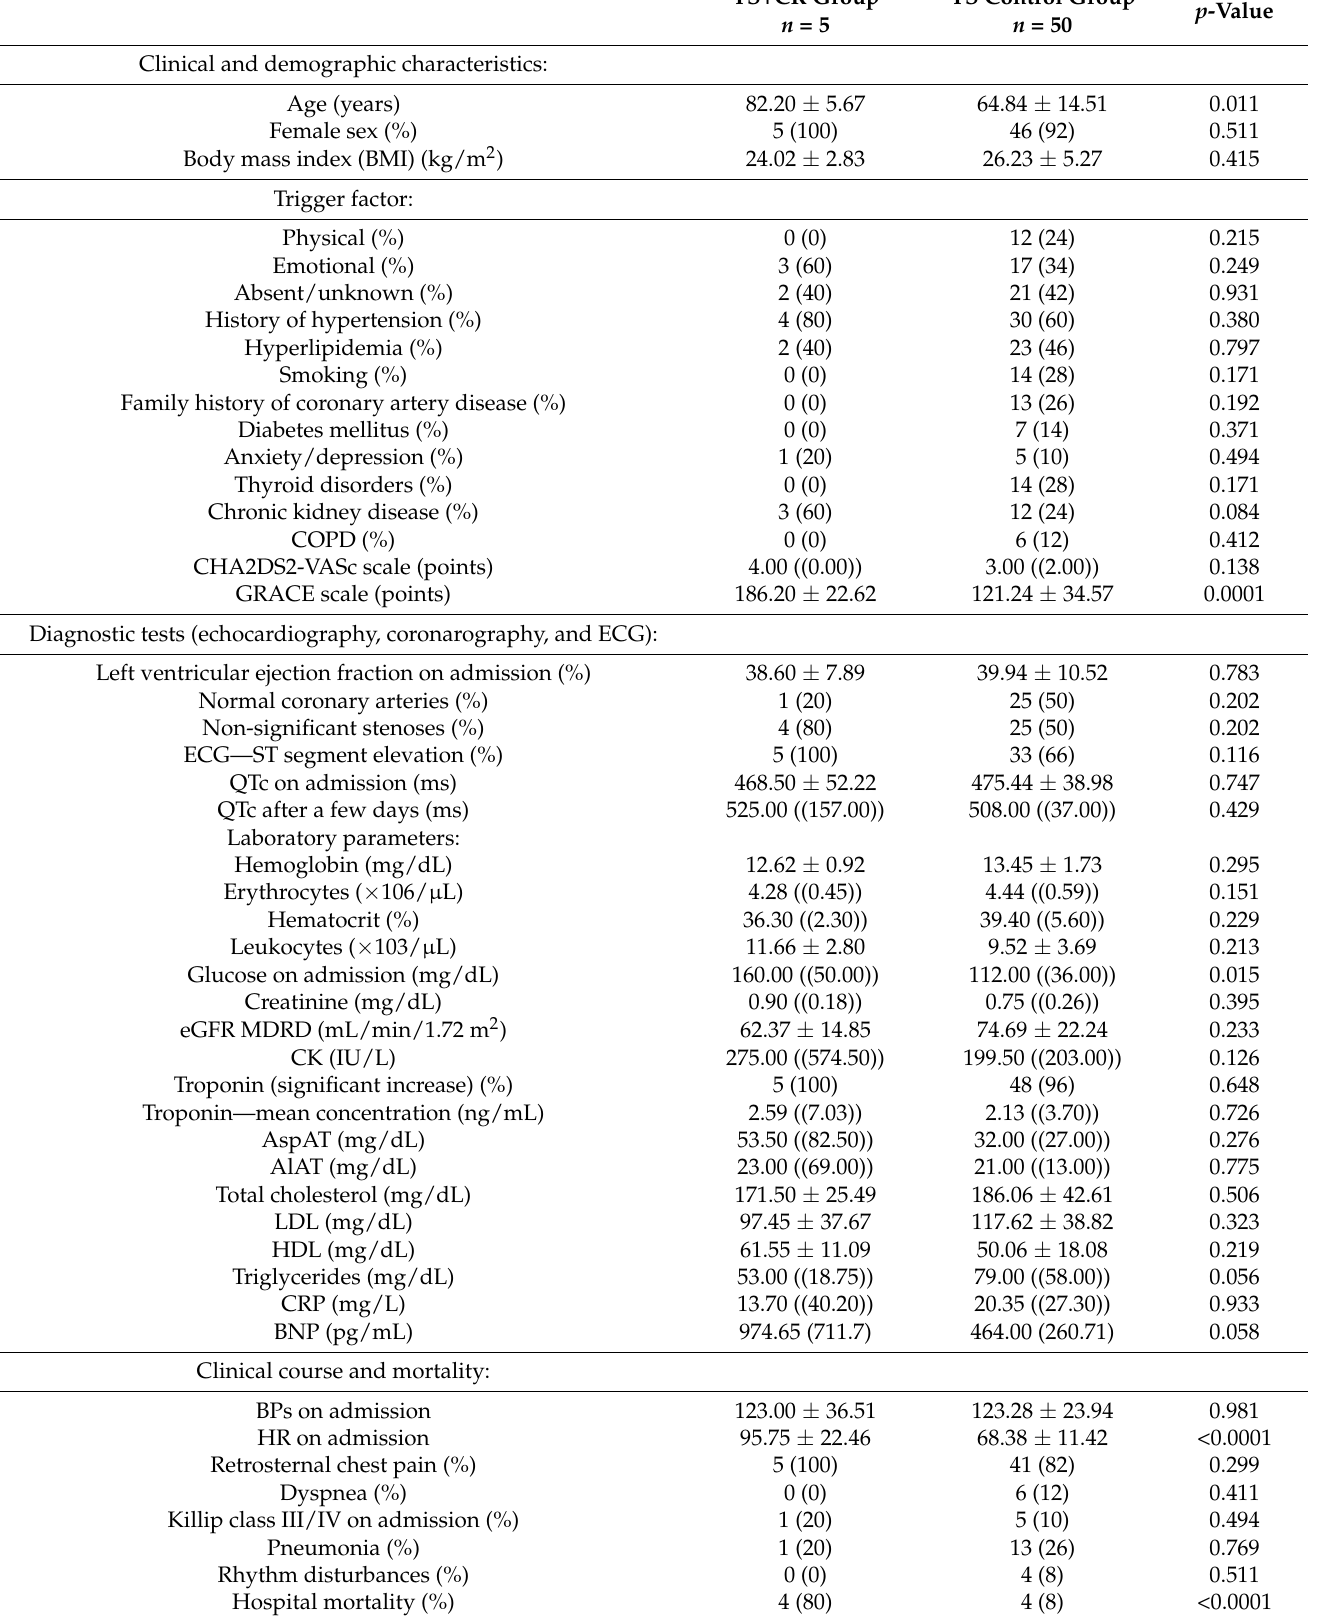
Table 1. Results comparison of the two